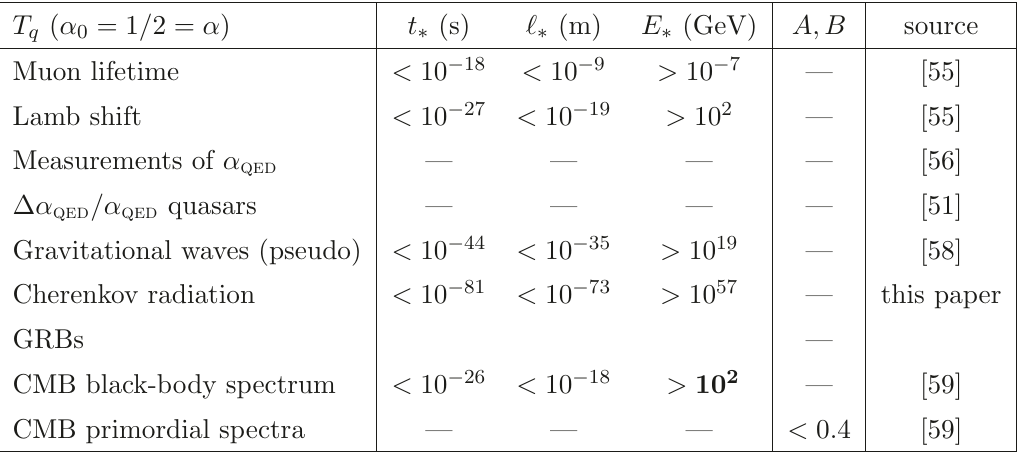
Table 7 . Bounds on the hierarchy of multifractional spacetimes with q -derivatives for α “Pseudo” indicates bounds obtainable in the stochastic view, where T q is regarded as an approxi- mation of T γ = α